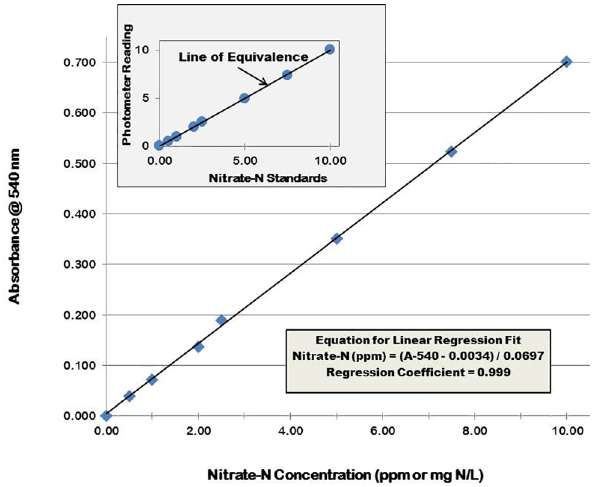
Fig 8. Nitrate Standard Curve used for calibration of the open-source photometer.